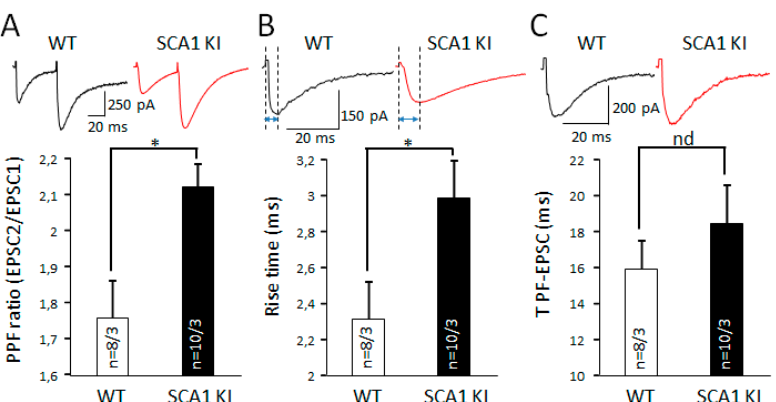
Figure 6. Properties of PCs are altered in three-week-old non-cell selective spinocerebellar ataxia type 1 (SCA1) model mice. ( A ) Average PPF ratio (second amplitude / first amplitude EPSC) in PCs from WT and SCA1 knock-in (KI) mice. In comparison with WT PCs, the PPF ratio significantly increased in SCA1 KI mice. Representative traces of PF-EPSCs are shown above. ( B ) The average rise time of PF-EPSCs in PCs from WT and SCA1 KI mice. In comparison with WT PCs, the rise time was significantly longer in SCA1 KI animals. Representative traces of PF-EPSCs are shown above. ( C ) Average decay time of PF-EPSCs in PCs from PBS and S100 β injected areas. No significant di ff erences. The represented traces of PF-EPSCs are shown above. * p < 0.05.